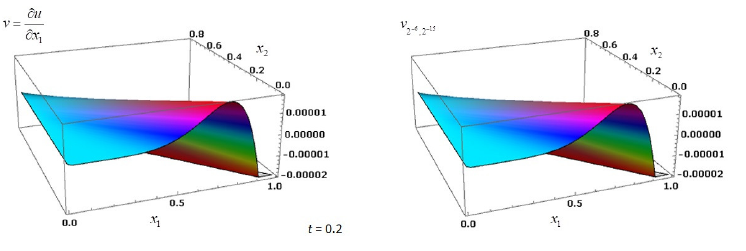
Figure 5. The exact solution v = ∂ u